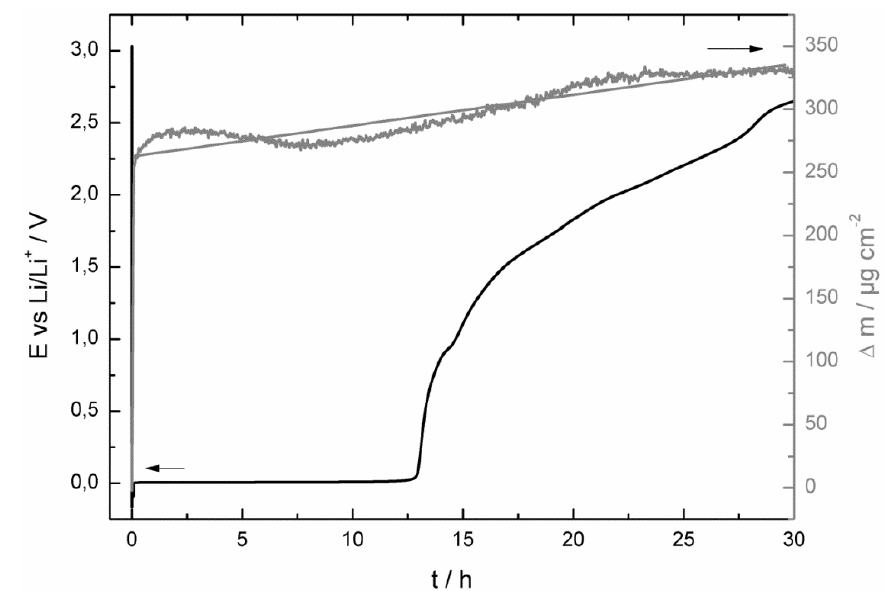
Figure 10. Time dependence of potential and attributed mass change during the first 30 h of the OCP measurement after lithium was deposited onto copper from 1 M LiPF EC:DEC (3:7, by